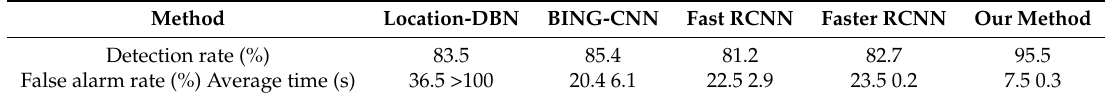
Table 3. Comparison of the proposed method with two comparative